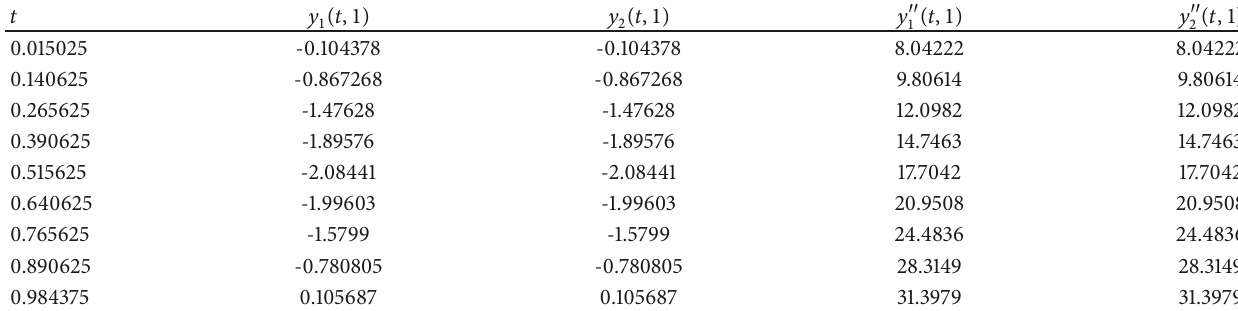
Table 1: In case of 𝑟 = 1 for Example 2.